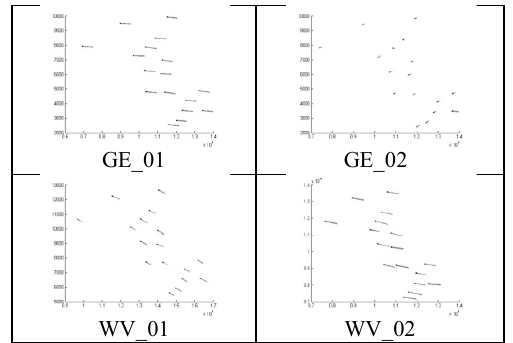
Figure 3. Bias vectors of